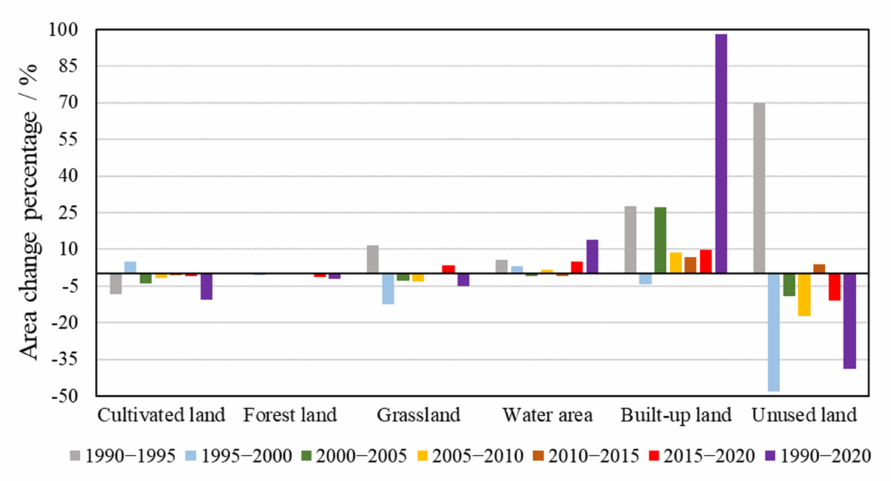
Figure 4. Area change rates of each land use type in Guangdong,